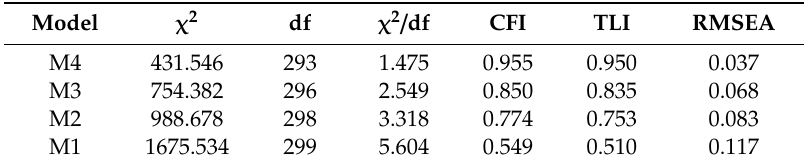
Table 1. Confirmatory factor analysis results.